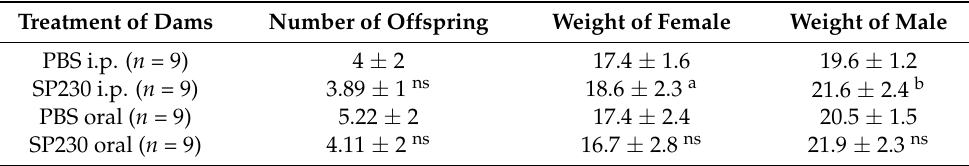
Table 1. Number and weight of offspring. CBA/J mice received PBS or 50 mg/kg of SP230 by intraperitoneal (i.p.) or oral route for 5 days during gestation. Weight of offspring was recorded at the age of 4 weeks. Results are expressed as mean ± standard deviation. Statistical differences were calculated with the Dunn’s multiple comparison test between the PBS i.p. and SP230 i.p. groups and between the PBS oral and SP230 oral groups ( ns not significant; a p value = 0.0437; b p value = 0.0236). Treatment of Dams Number of Offspring Weight of Female Weight of Male PBS i.p. ( n =